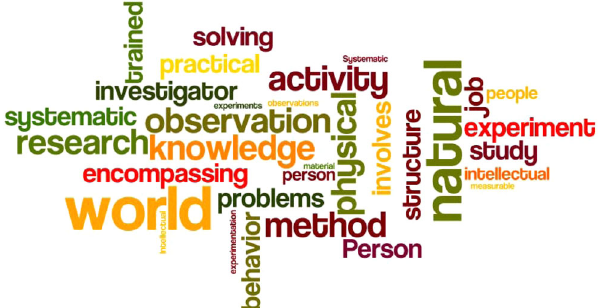
FIG. 2. Wordle created from student definitions of science and scientists, from their second short paper.